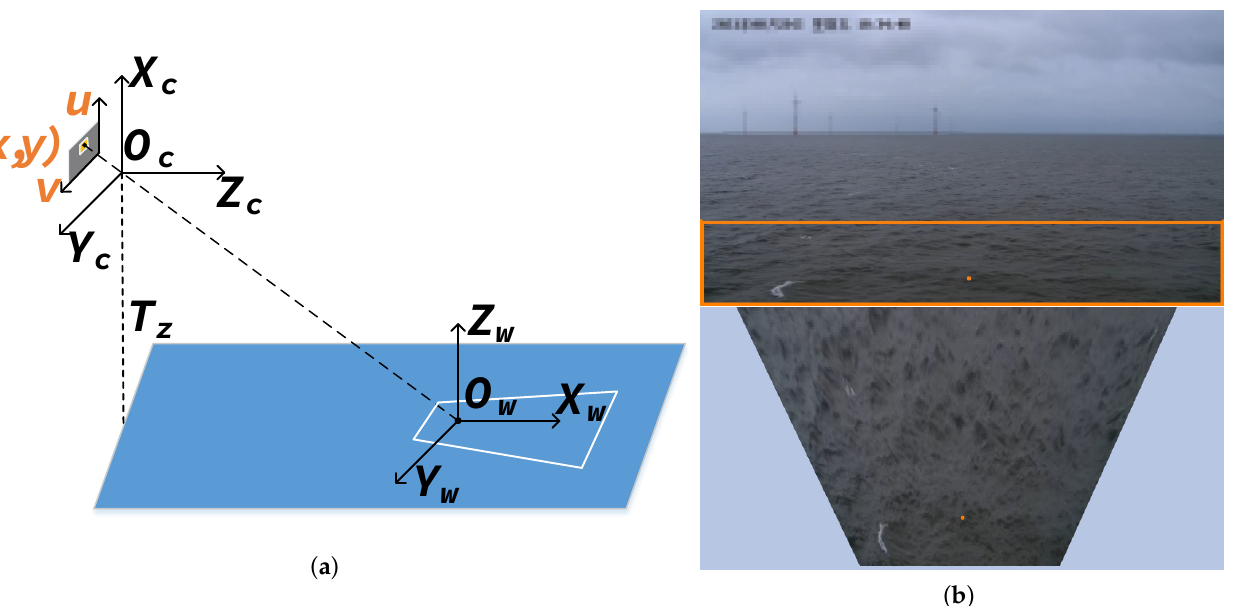
Figure 1. ( a ) Instrumentation; ( b ) wind speed and significant wave height data in video clips analyzed in this study.